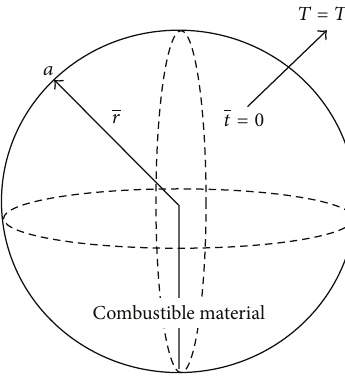
Figure 1: Geometry of the